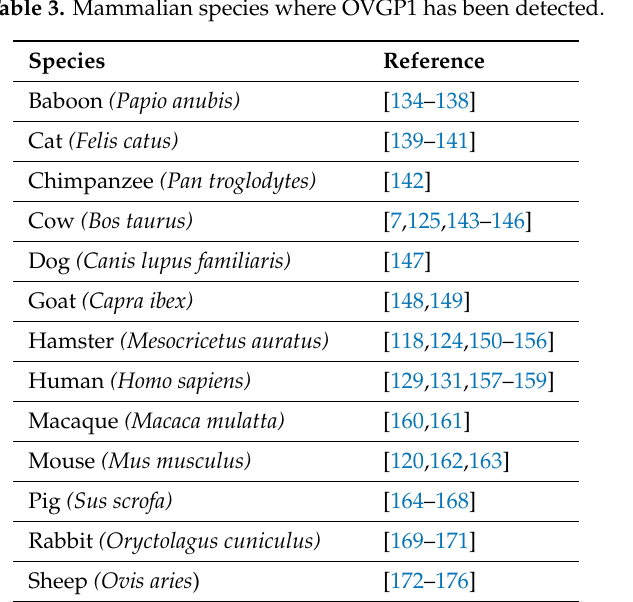
Table 3. Mammalian species where OVGP1 has been